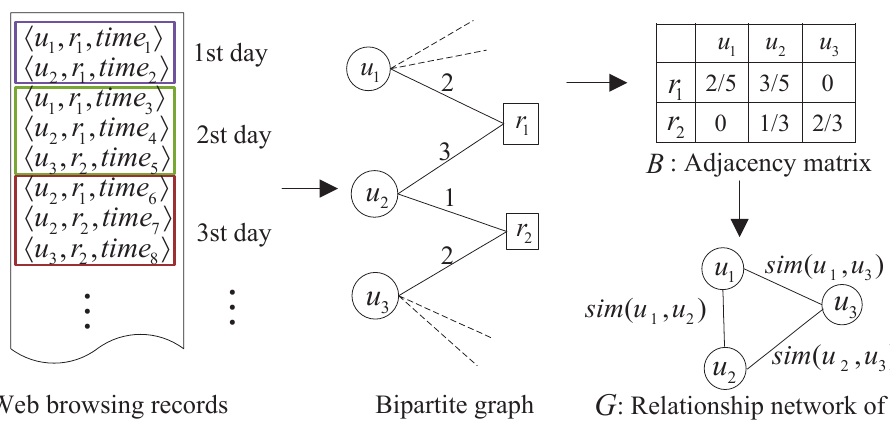
Figure 6. An example for the construction procedure of relationship network of